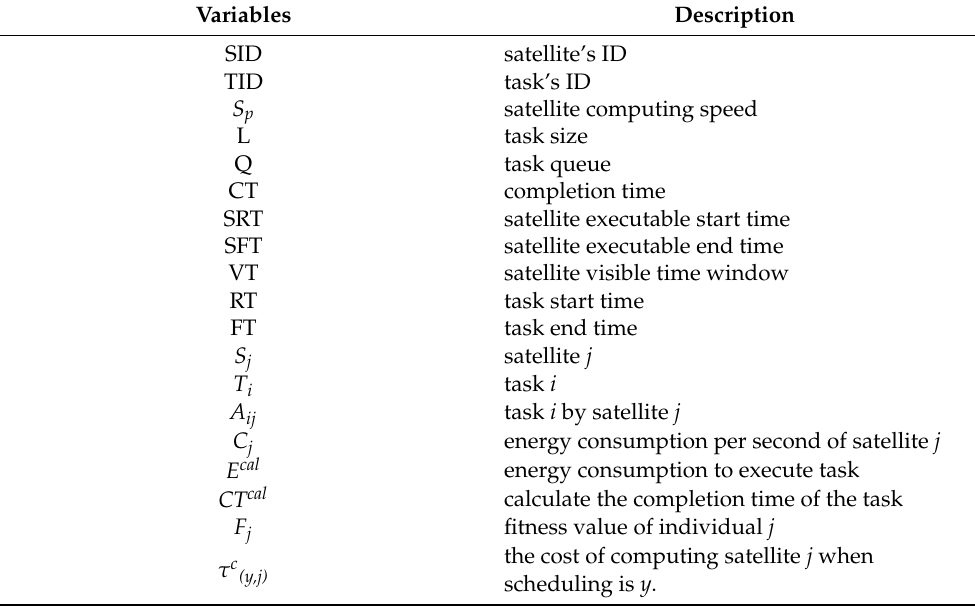
Table 1. Variable noun description used in this